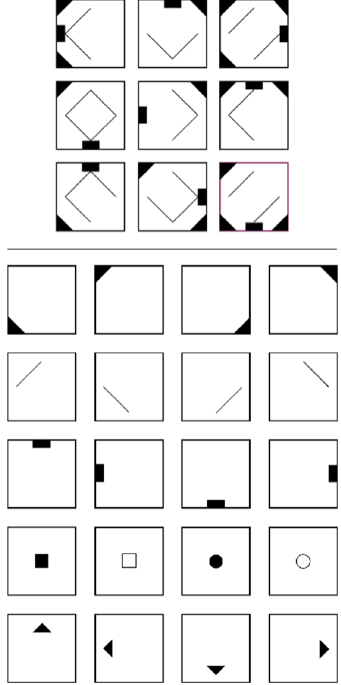
Figure 1. The figure shows an item with three rules (solution field in violet filled for demonstration purpose): (rule 1) The triangles in the corners of the first and second cells sum up in the third cell in each row. (rule 2) The rectangle rotates around the edges of the cells in each row. (rule 3) Only lines that are present in the first or the second cell are present in the third cell in each row.